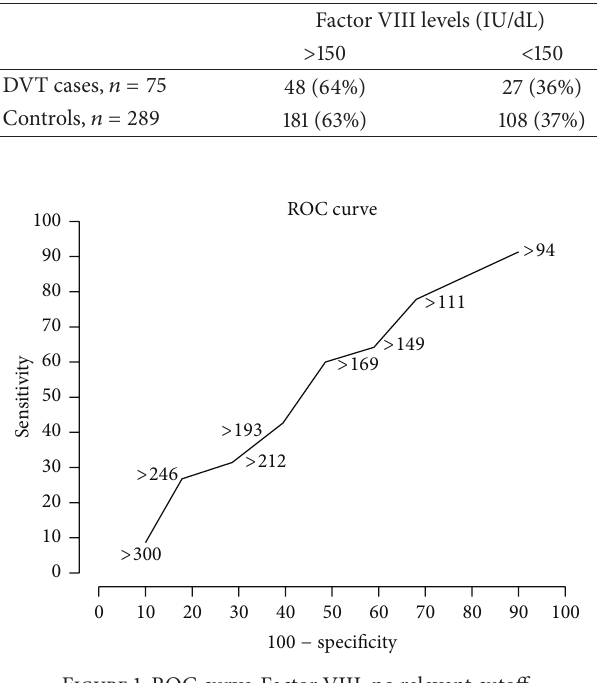
Figure 1: ROC curve-Factor VIII, no relevant